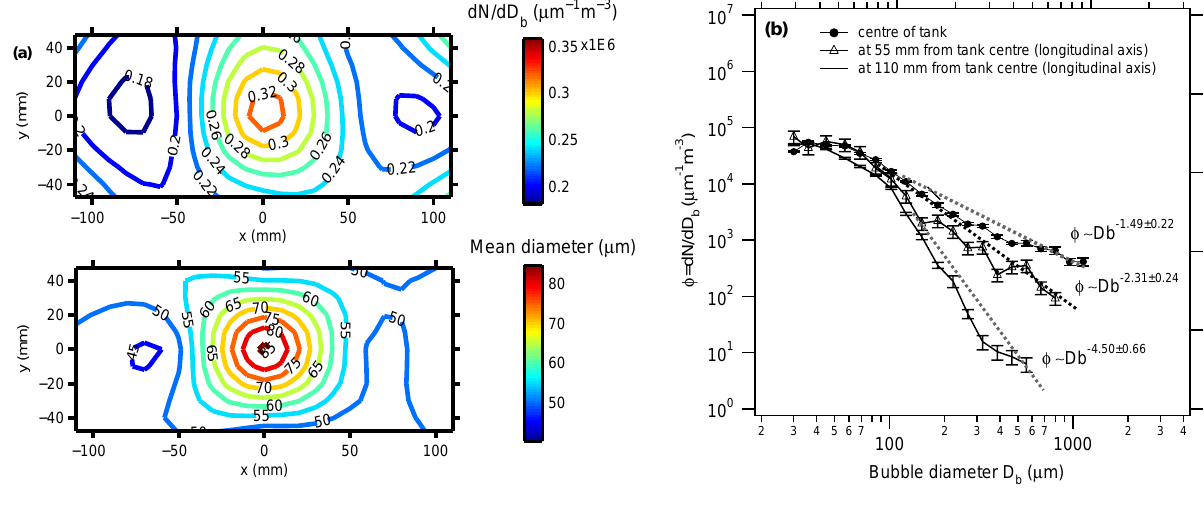
Fig. 5. (a) Spatial distribution of total number and mean size of bubbles generated by the plunging-waterjet system (1.8lpm water recir- culation flow) and (b) bubble spectra at impingement, 55mm and 110mm from the tank centre. Error bars indicate the variability of the measurements as ± 1 σ standard deviation.